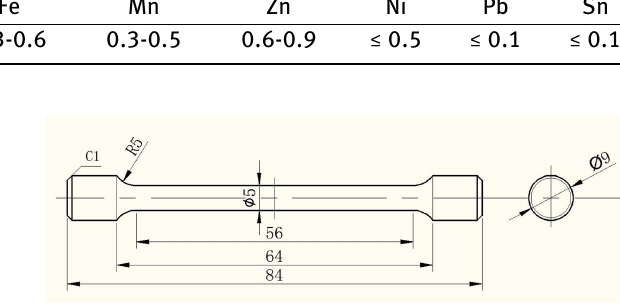
Table 1: Chemical composition of ADC12 wt% Al